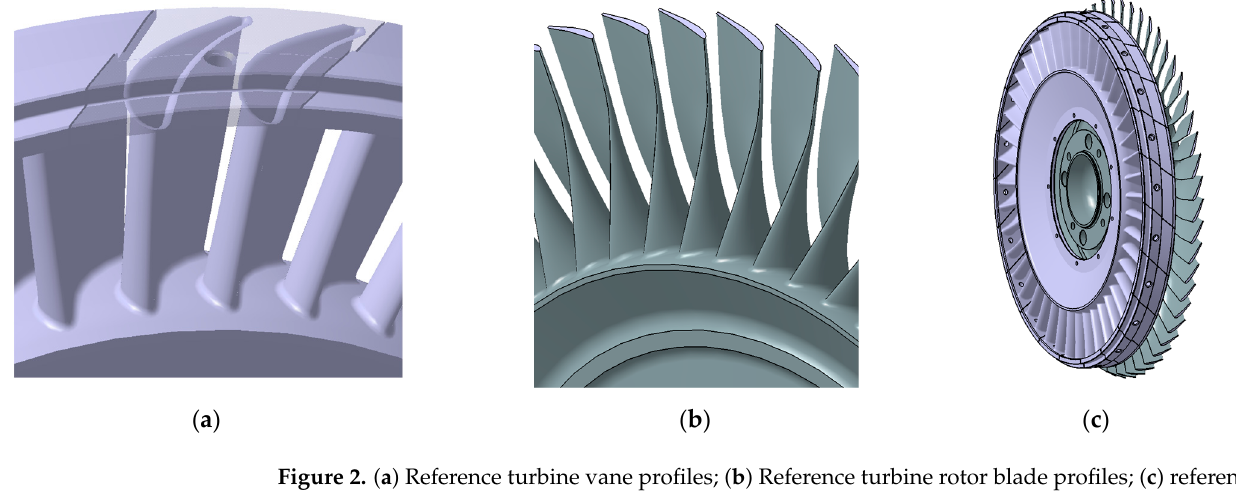
Figure 1. Study methodology for injection method characterization.